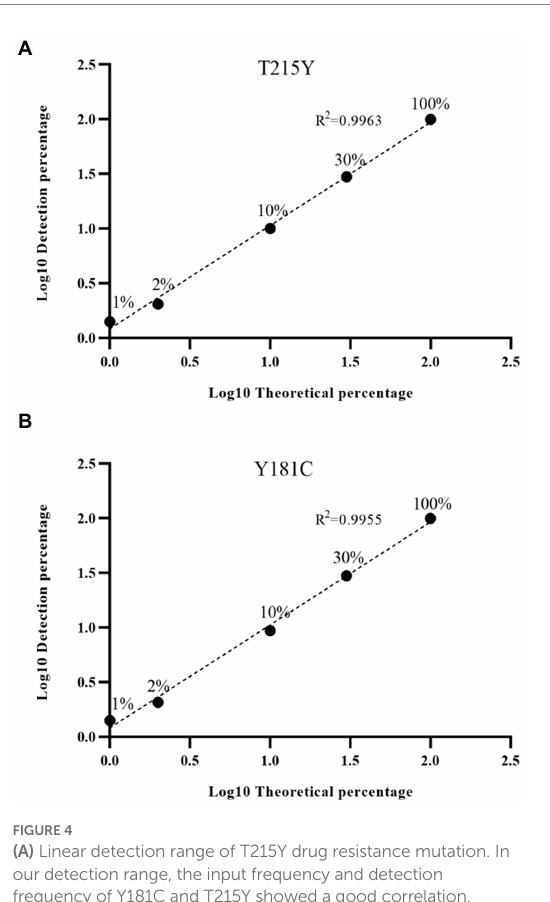
FIGURE 4 (A) Linear detection range of T215Y drug resistance mutation. In our detection range, the input frequency and detection frequency of Y181C and T215Y showed a good correlation. (B) Linear detection range of Y181C drug resistance